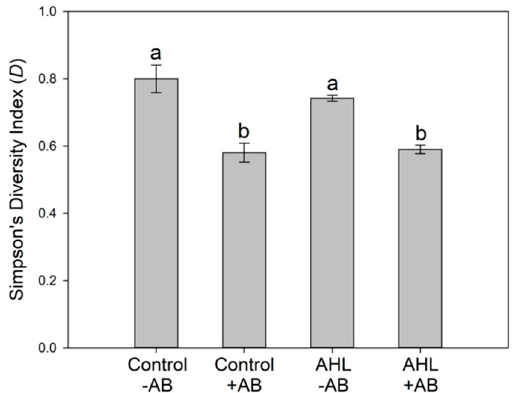
Figure 7. Simpson’s diversity indices of the Medicago root-associated bacterial community. Different letters above the bars indicate a statistically significant difference between groups ( p < 0.05; one-way ANOVA with Tukey’s post hoc test, n = 3). AB = antibiotic treatment; AHL = 3-oxo-C 14 -HSL treatment.